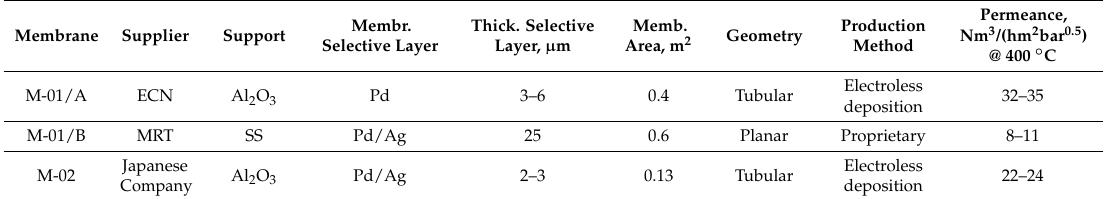
Table 2. Main characteristics of the employed membranes. Membr. Selective Layer